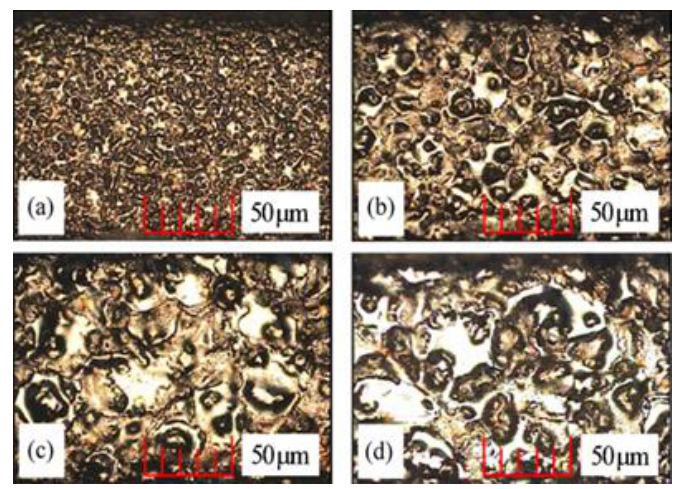
Figure 27. The surface roughness caused by various peak currents: ( a ) 1.5 A (0.715 µm), ( b ) 3 A (0.796 µm), ( c ) 5 A (0.855 µm) and ( d ) 6 A (0.994 µm) [187].